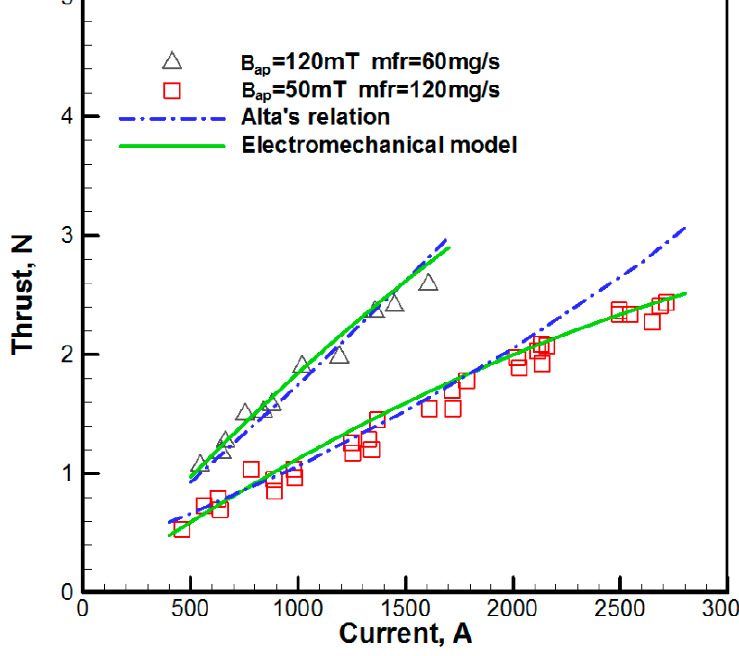
Figure 4. Variations of theoretical and experimental thrust with currents.